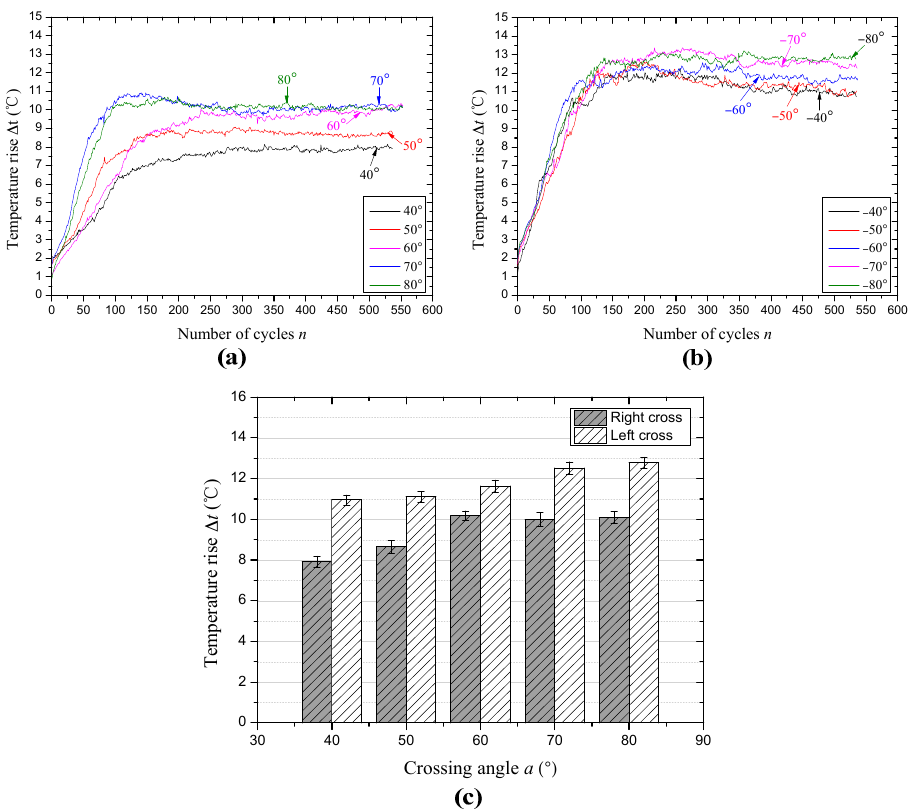
Figure 10. The evolution of the temperature rise under different sliding conditions ( x : 20 mm; v : 12 mm/s). ( a ) Right cross contact; ( b ) left cross contact and ( c ) the average values of the temperature rise in the steady-state period.